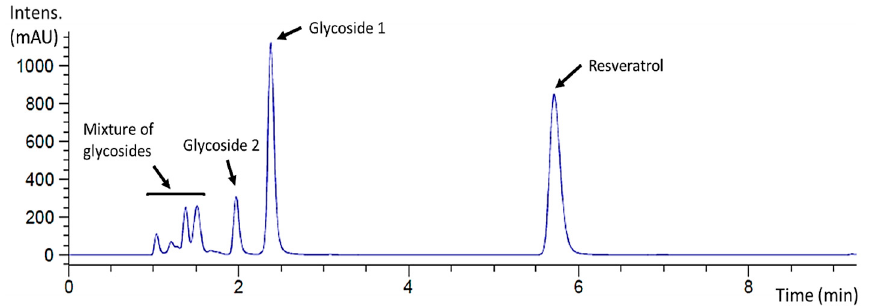
Figure 2. HPLC chromatogram ( λ = 270 nm) of the standard resveratrol glycosylation reaction catalyzed by rXynSOS-E236G glycosynthase using X 2 F as the donor. The resveratrol used as the acceptor eluted at 5.71 min, the major peak (2.38 min) corresponding to a reaction product was labeled as glycoside 1 and the minor one (1.97 min) as glycoside 2 . A mixture of potential resveratrol glycosides eluted earlier.